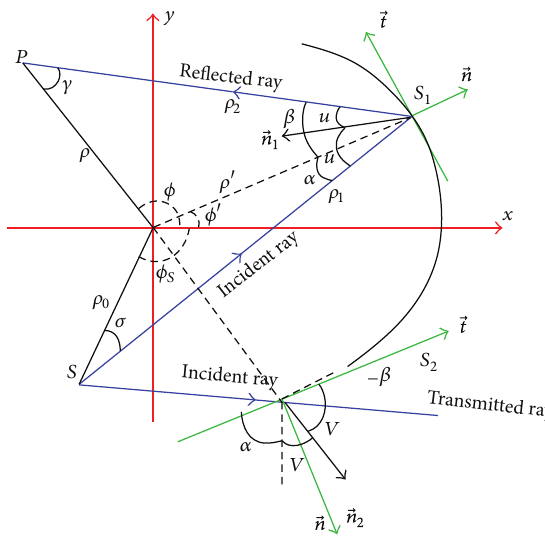
Figure 1: The 𝑥𝑦 -plane cross-section of the source and PEC